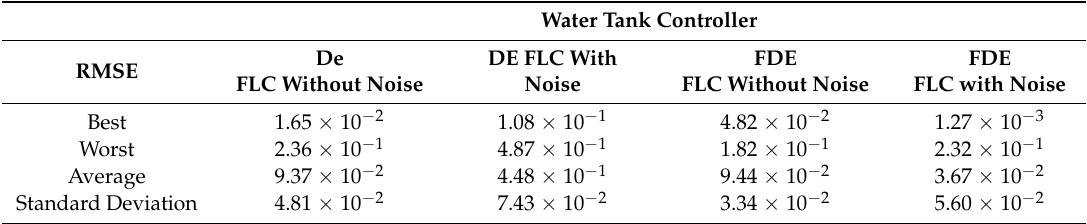
Table 8. Results obtained from the water tank controller by DE and FDE algorithm.